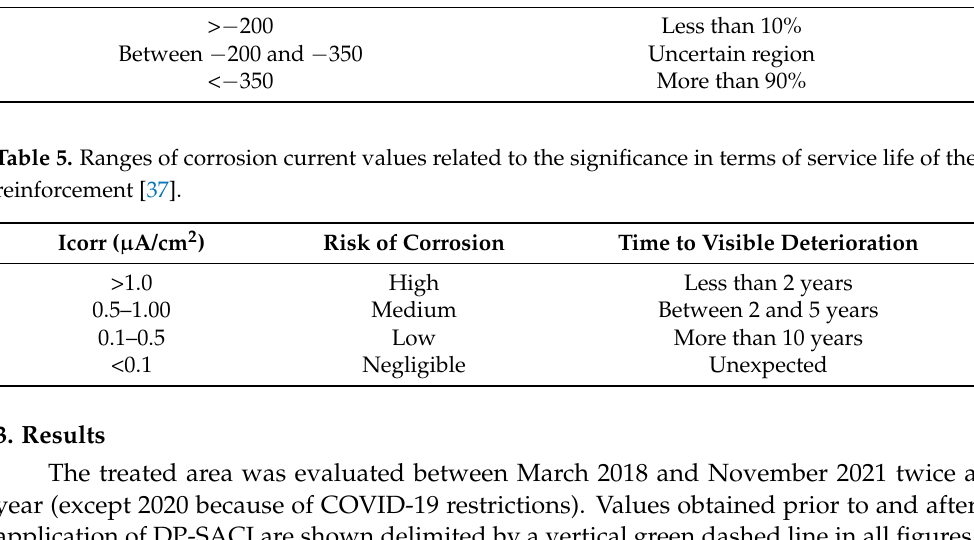
Table 6. Reference test points at the treated area.